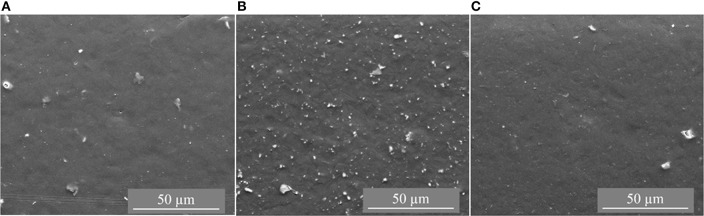
Top surface SEM images of 8 wt% (A), 16 wt% (B) and 24 wt% (C) of CTF-1@PSF composite MMMs.